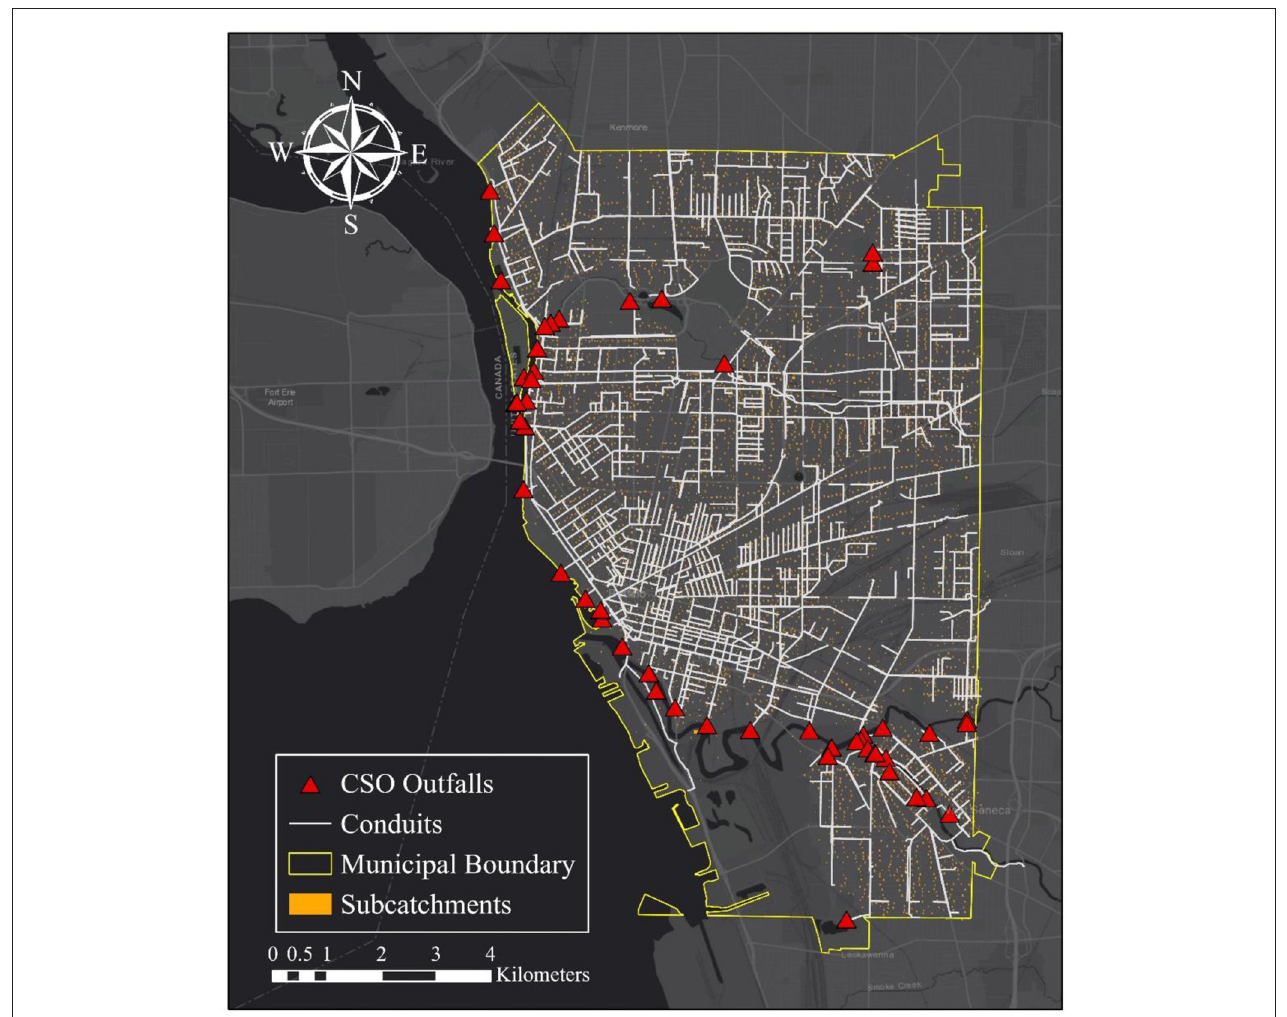
FIGURE 1 | City of Buffalo’s SWMM Model—conduits, sub-catchments, and CSO outfalls.